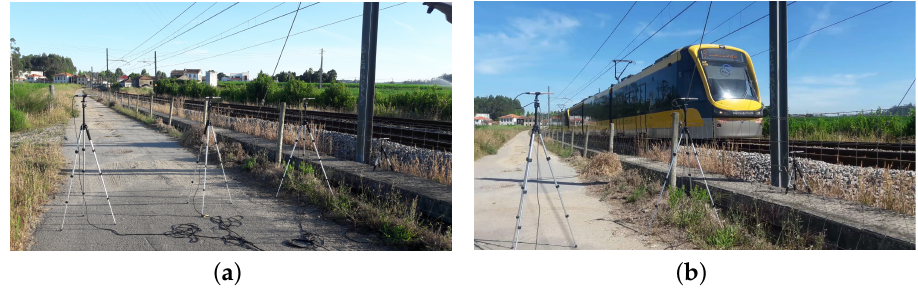
Figure 4. Photographs of the in situ experimental characterisation. ( a ) Photograph of the microphones on site. ( b ) Photograph of the measurement setup in the presence of the vehicle. The sound pressure levels (SPL) collected in a ballast track context in each of the four